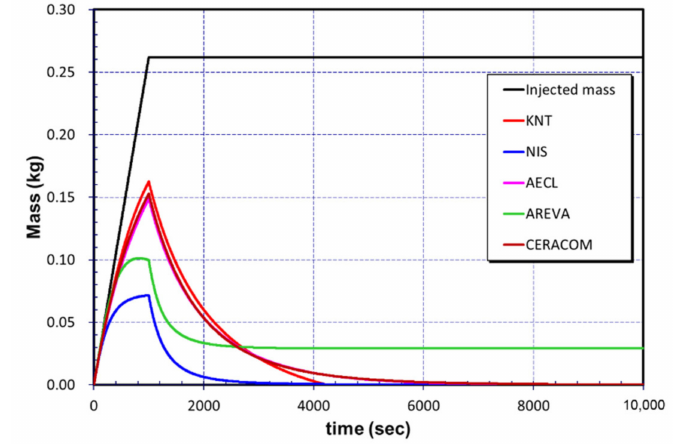
Figure 7. Comparison of the PAR performances (hydrogen inventory) by di ff erent manufacturer’s